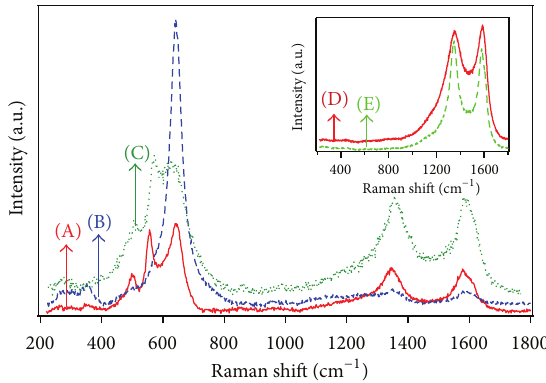
Figure 3: Raman spectra of (A) wpCNTs/MnO 2 (75 W, 135 Pa) before cycling, (B) wpCNTs/MnO 2 (75W, 135 Pa) after 2000 cycles (between 0-1V), and (C) wpCNTs/MnO 2 (75W, 135 Pa) after 2000 cycles (between 0.1–0.8 V). Inset figure shows Raman spectra of (D) untreated CNTs and (E) wpCNTs (75 W,